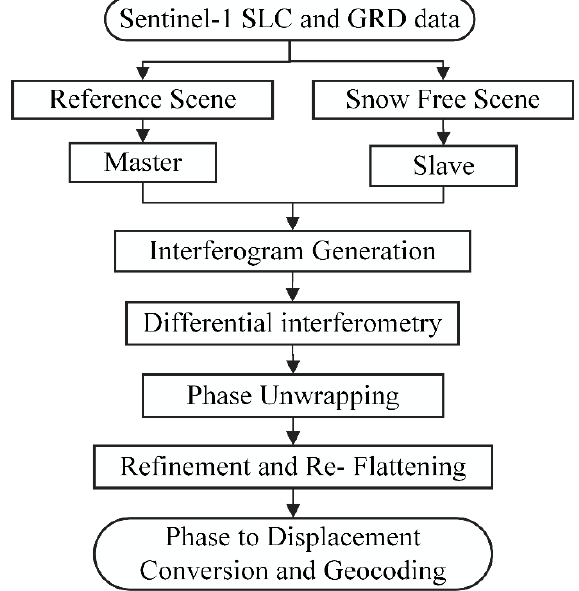
Figure 3. Flowchart for the generation of DInSAR line of sight (LOS) displacement.